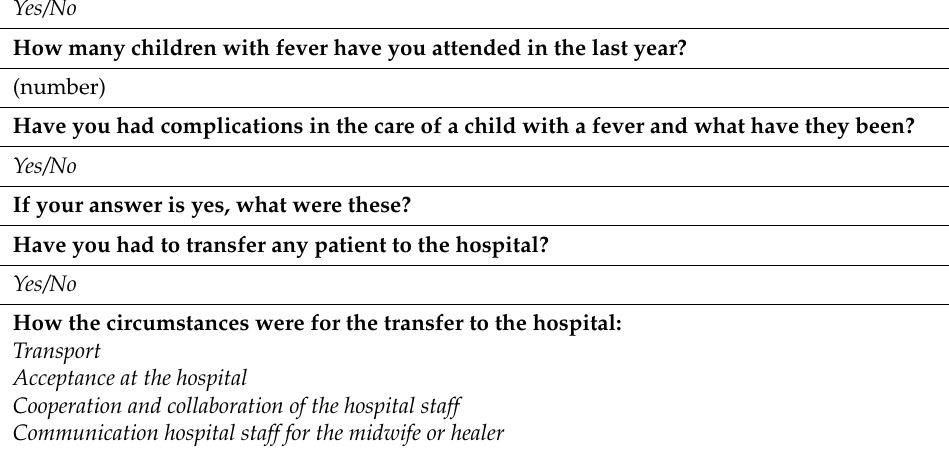
Table 2. Evaluation